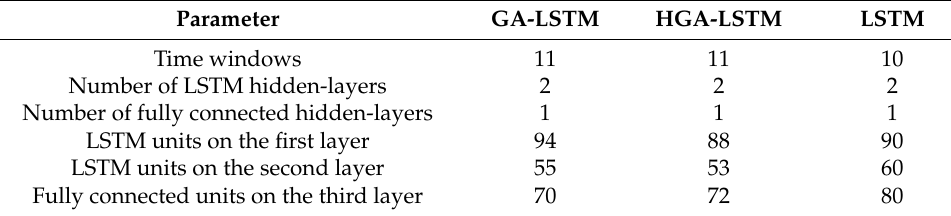
Table 2. Specific optimization outcomes based on GA and